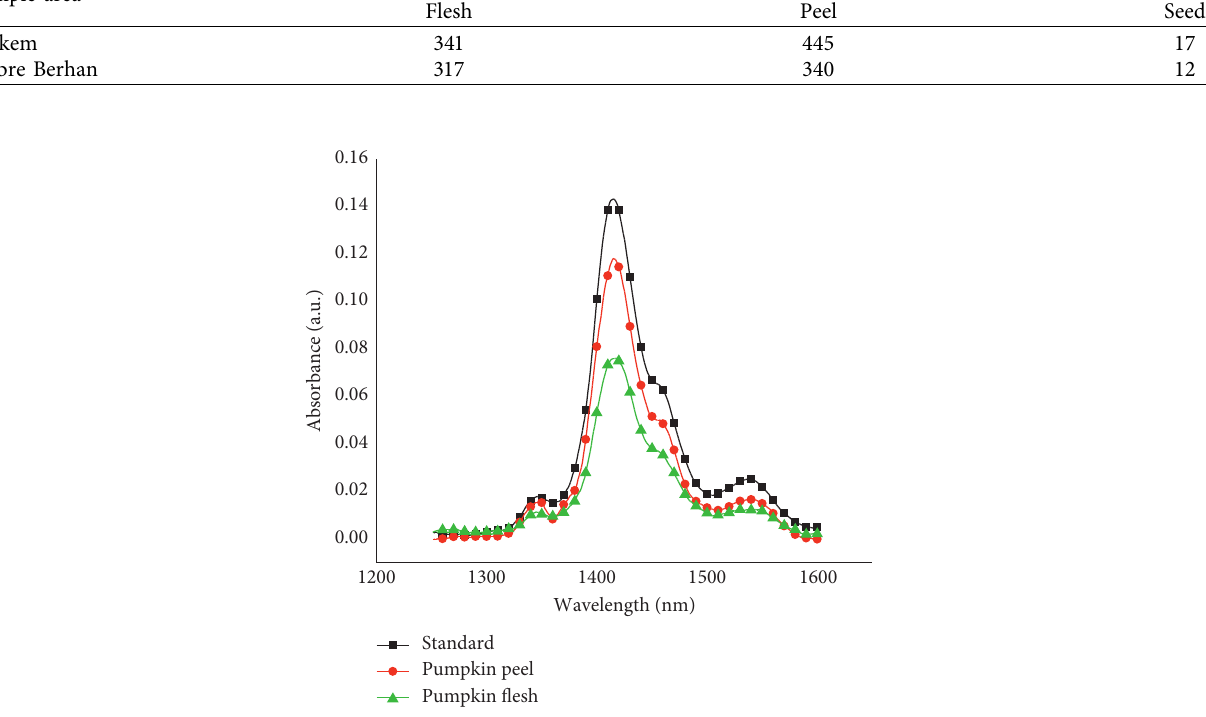
Figure 6: NIR spectra of standard β -carotene and β -carotene from pumpkin flesh and peel with acetone extracts.